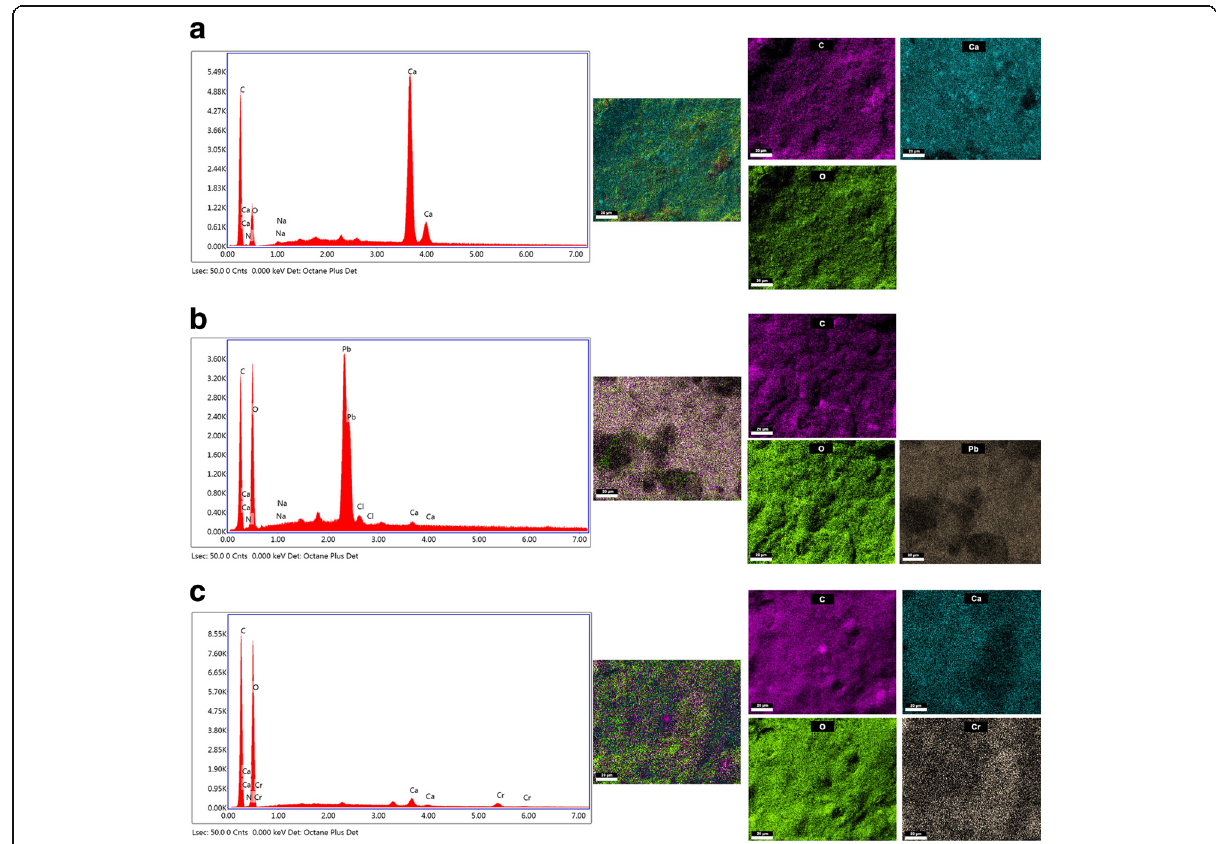
Fig. 4 EDX and elemental mapping of the CSM/SA hybrid beads: a before metal adsorption, b after Pb(II) loading, c after Cr(VI)